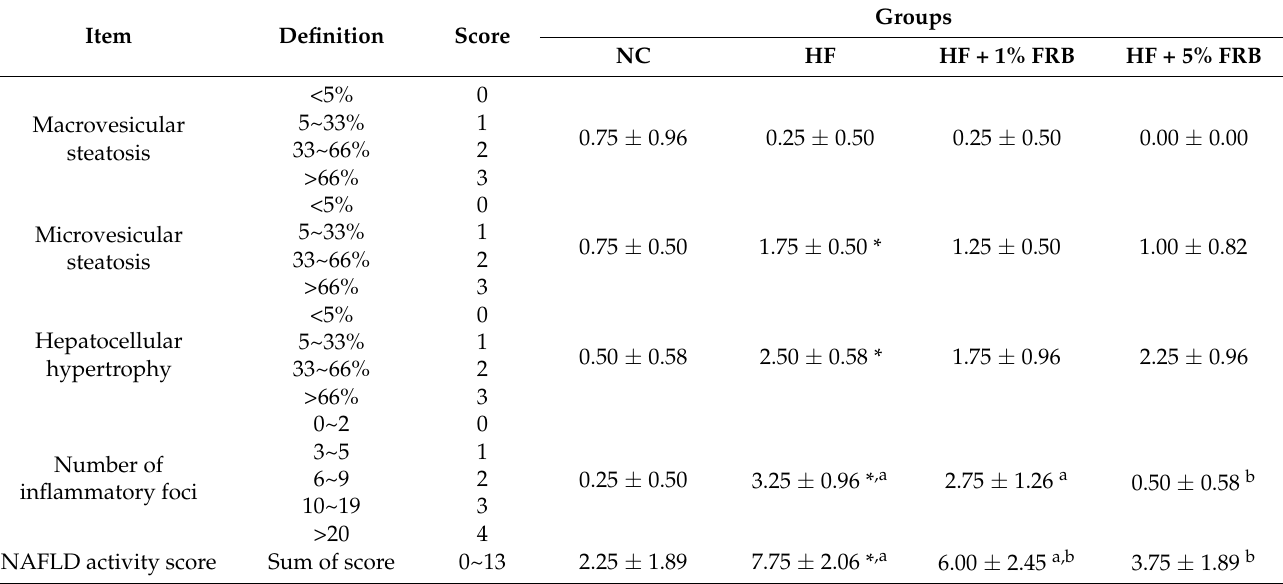
Figure 4. Effects of the water extract of fermented rice bran (FRB) on liver histopathological changes in aged rats with high-fat (HF) diet feeding. ( A ) H&E staining. Magnification: ×200. Scale bar, 25 µ m. (Yellow arrow: inflammatory cell infiltration; yellow star: lipid droplets.) ( B ) Histopathological analysis scores. Values are presented as the mean ± standard deviation ( n = 4). * p < 0.05 vs. the normal control (NC) group; significance between two groups was determined using Student’s t -test. In the HF diet-fed groups, different letters indicate significant differences between groups at p < 0.05 by a one-way ANOVA with Fisher‘s post hoc test. NAFLD, nonalcoholic fatty liver disease. Table 2. Histopathological analysis scores.